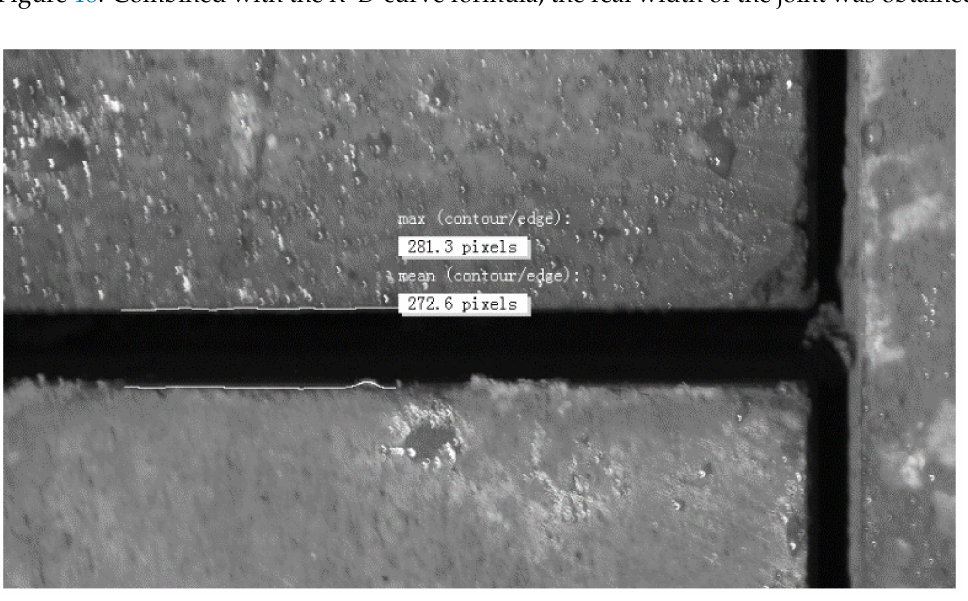
Figure 18. Segment joint width